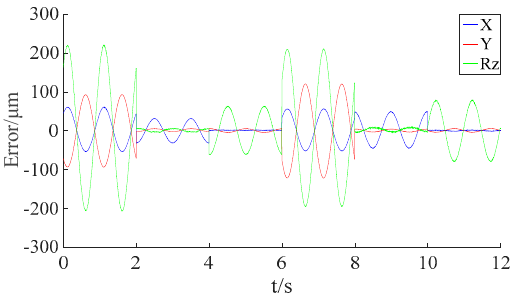
Figure 10. The output errors of the Hall sensor array with the designed parameters using Model (15) when the stage is on a different vertical level.